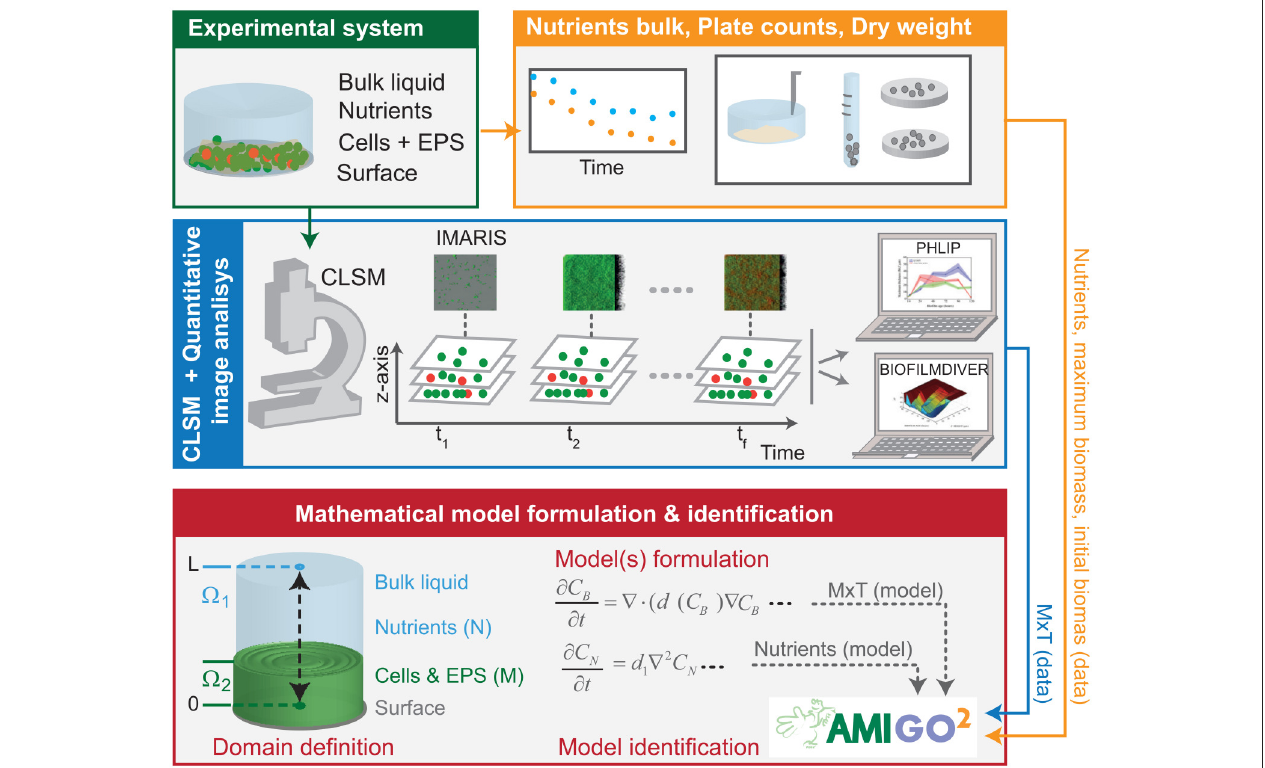
FIGURE 1 | Model identification scheme based on CLSM and nutrients consumption measurements. Biofilms were grown under static conditions. CLSM was used to gather image stacks in several sampling times. IMARIS allowed reconstructing 3D-structures and quantifying maximum biofilm thickness throughout time.